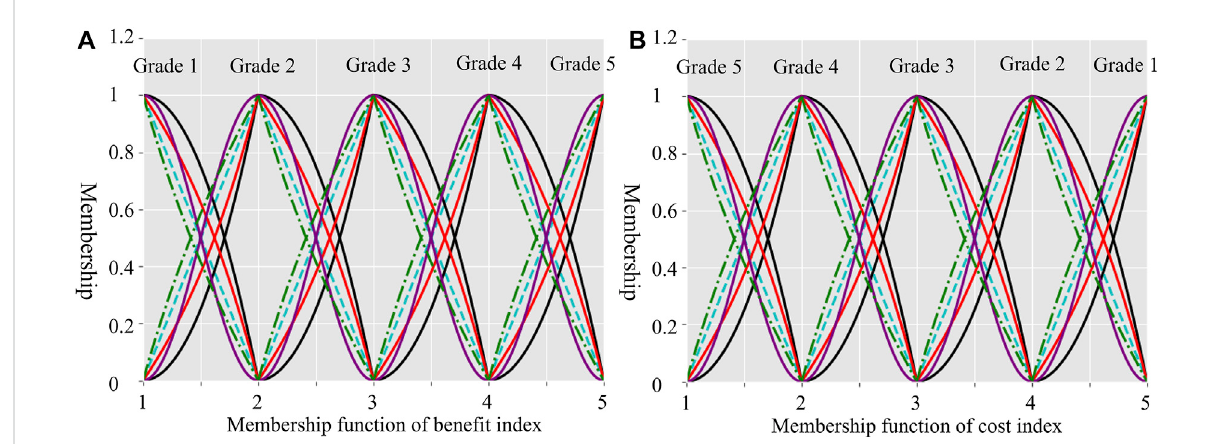
FIGURE 3 Membership function for different indexes. (A) Membership function of bene fi t index, and (B) Membership function of cost index.